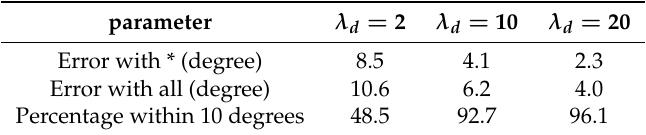
Figure 7. Visualizations of the Field’s results on the DOTA dataset. The first column is the original image overlying with the object ellipse and its bounding rectangle, the second column is the Center Field, the third column is the direction diagram and the last column is the Direction Field. Table 6. Direction error on DOTA. λ d is defined in Equation (2). Error with * indicates that we regress the Direction Field of the objects with * in the Table 5. Error with all means that we regress the Direction Field of all objects. Experiments show that for some objects that have no direction, or symmetric objects, such as storage tanks, direction regression will reduce the accuracy of overall direction